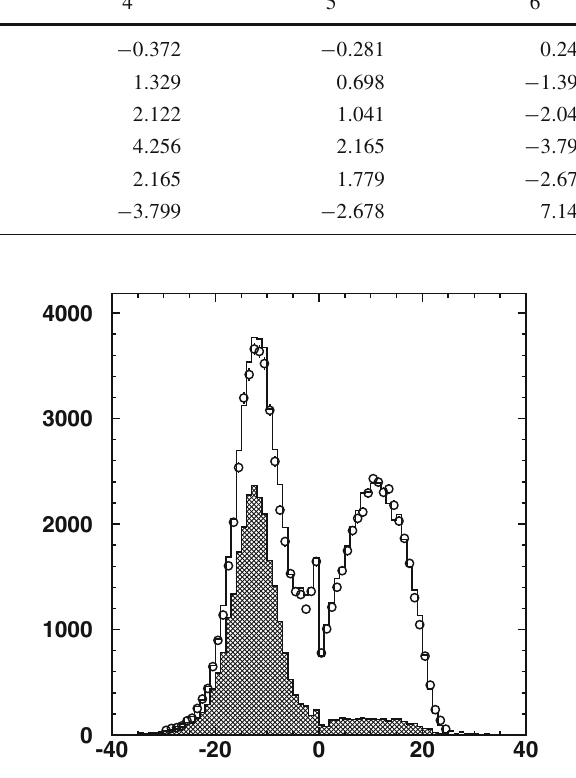
Fig. 21 ThelikelihoodofthenumberofCherenkovrings.Thoseevents that have a likelihood less than or equal to 0.0 are corresponding to have one ring; those above 0.0 are to be multi-ring. Data are the circles and MC is the histogram. The shaded histogram is for CC QE events in MC